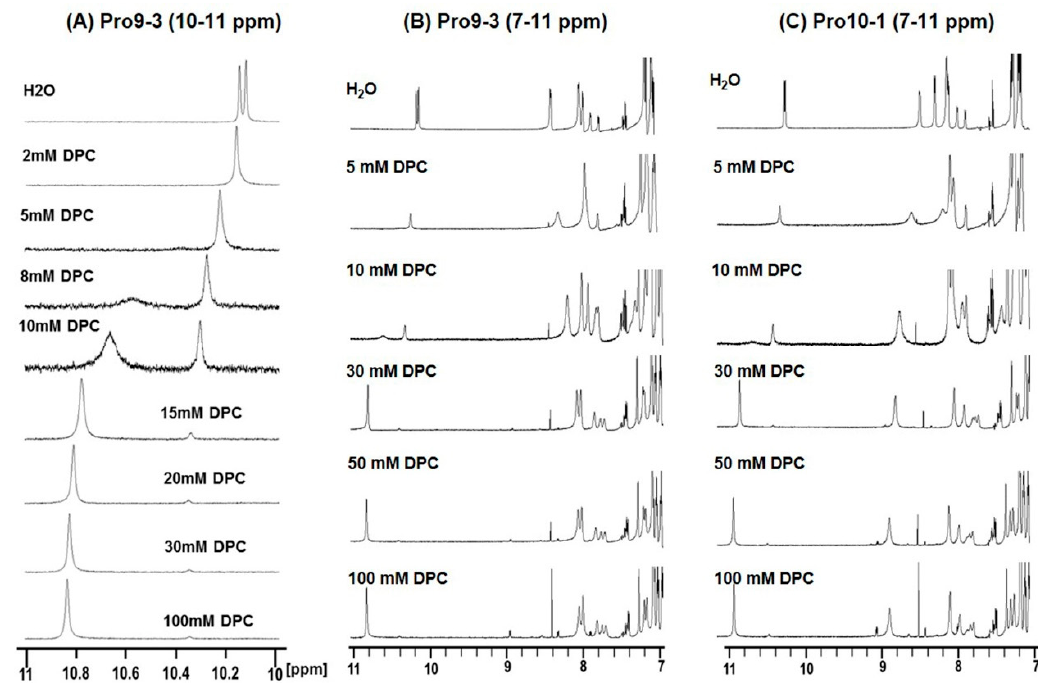
Figure 4. Chemical shift perturbations in the NH region of the 1 H NMR spectra at 298 K in 9:1 ( v / v ) H 2 O / D 2 O induced by dodecylphosphocholine (DPC): Sets of 1D 1 H NMR spectra of a 1 mM solution of peptides were acquired with 128 scans. One-dimensional 1 H NMR spectra of Pro9-3 were recorded with 9 di ff erent concentrations of DPC from 10 to 11 ppm ( A ), and 1D 1 H NMR spectra of Pro9-3 ( B ) and Pro10-1 ( C ) from 7 to 11 ppm were recorded for six di ff erent concentrations of DPC. Changes in chemical shifts and line broadenings in the spectra of the peptides upon addition of DPC indicate conformational changes and interactions with DPC.